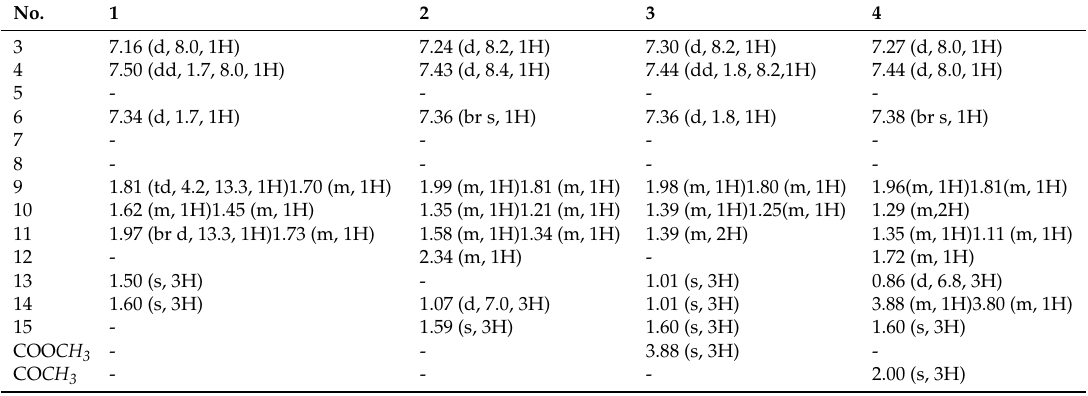
Table 2. The 1 H-NMR data of compounds 1 – 4 (400 MHz, CD 3 OD- d 4 ).